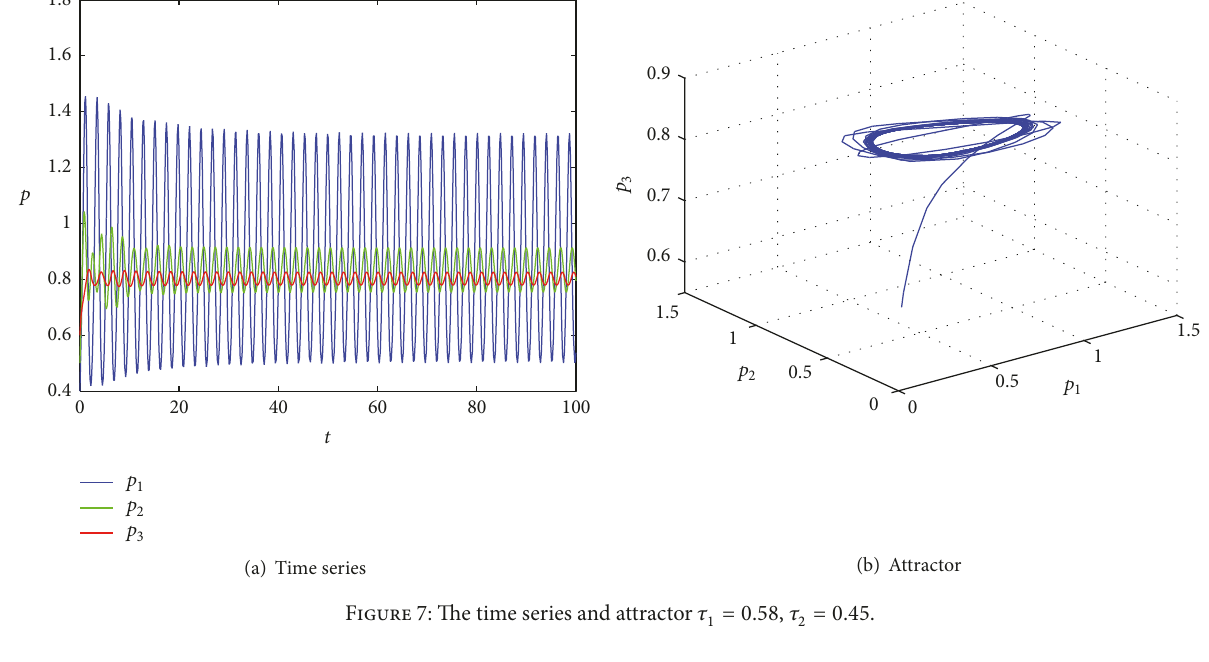
Figure 7: The time series and attractor 𝜏 1 = 0.58 , 𝜏 2 = 0.45 .